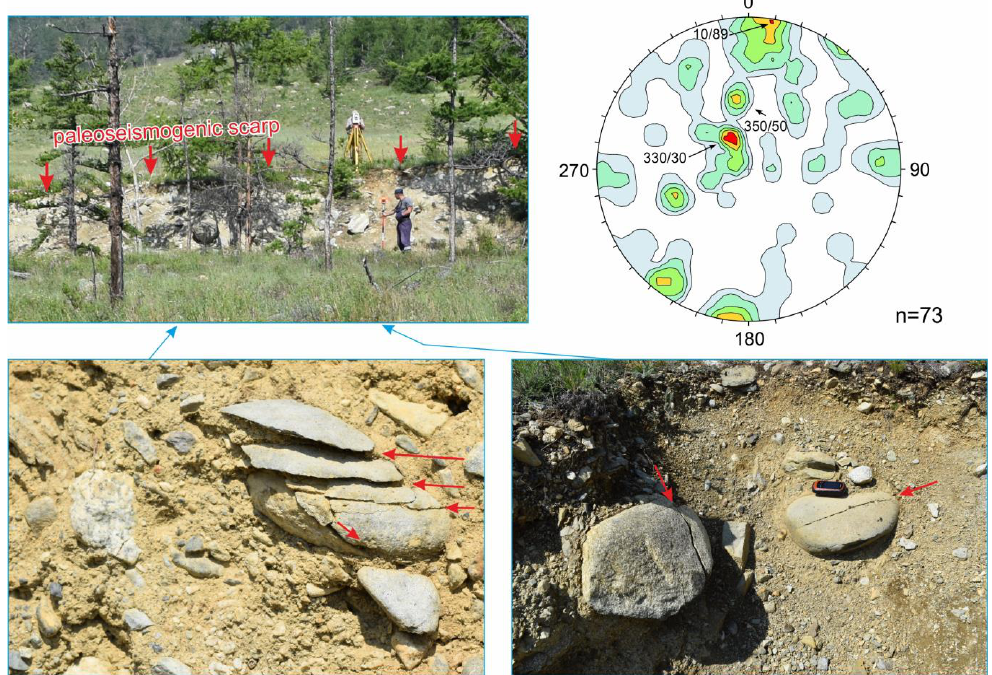
Figure 9. Fractures in pebbles shown by red arrows in site 5, which is located on the seismogenic scarp associated with rupture R - 9, and fractured diagram (see location in Figure 4, Wulff upper hemisphere projection; n—number of measurements; counting circle size 1%; intensity isolines are 1, 2, 3 and >; >; different colors show density concentration from 0 (white) to > 9 (red)).